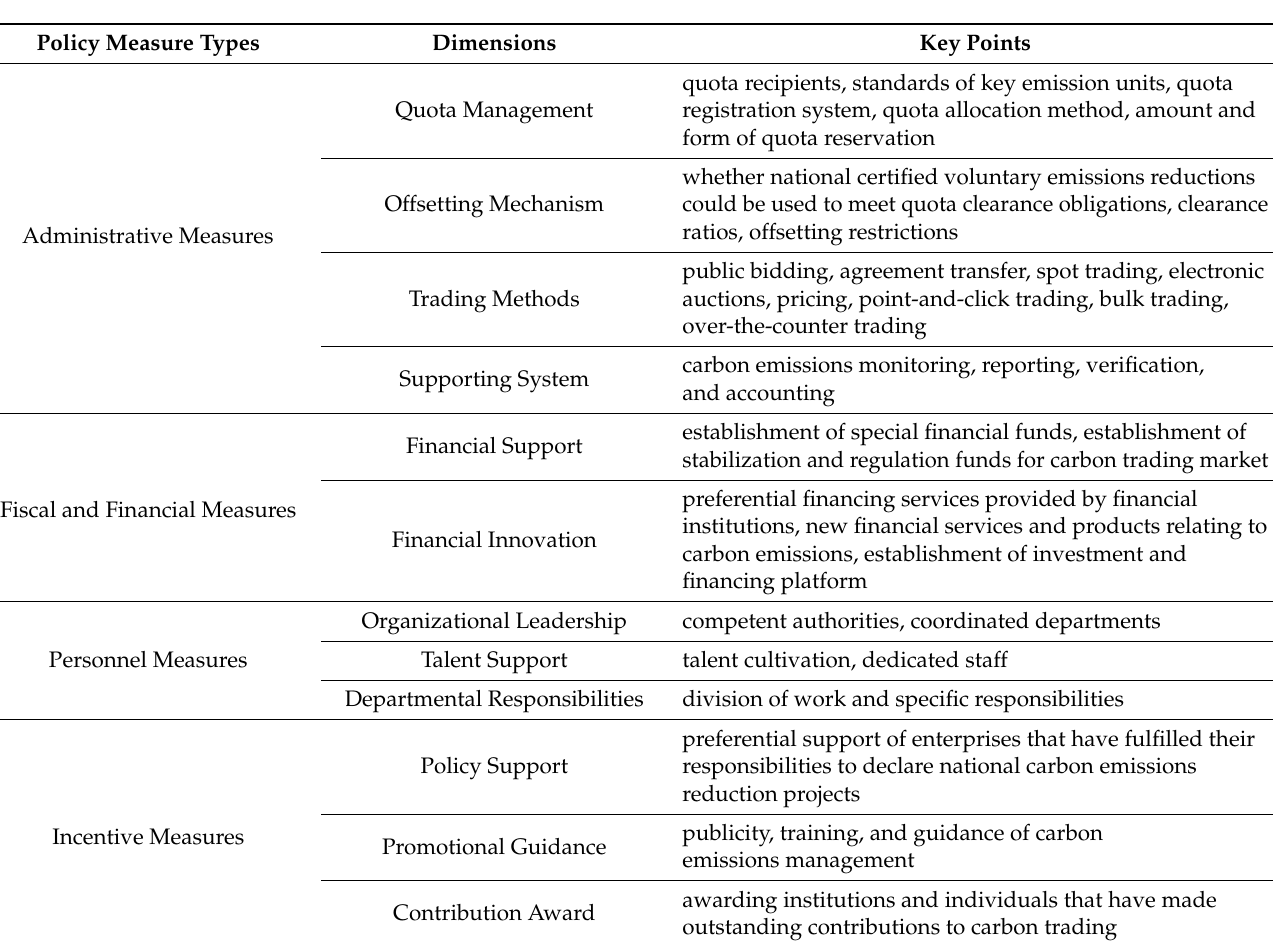
Table 3. Types, dimensions, and key points of policy